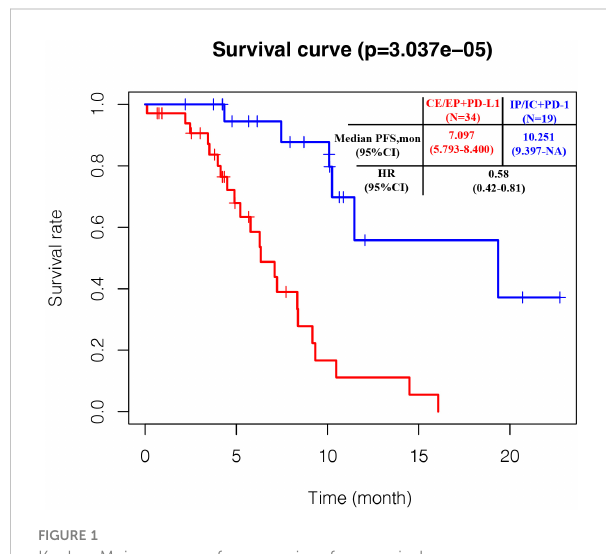
FIGURE 1 Kaplan-Meier curves of progression-free